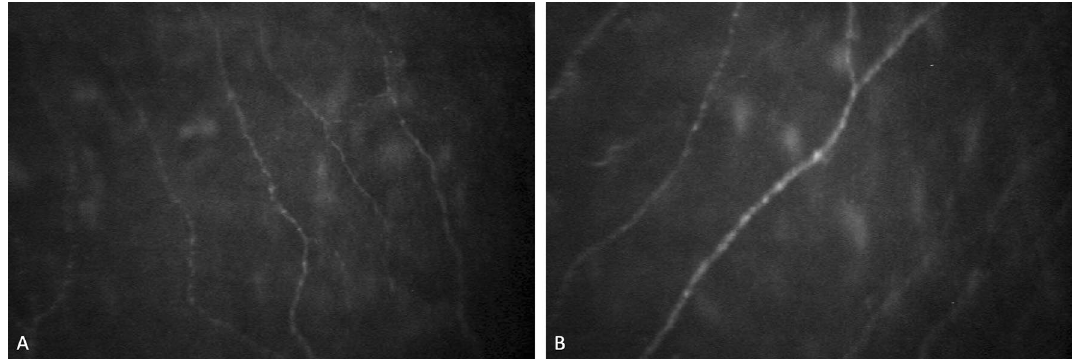
Figure 4. The SBNP fibers picture of the eye with emmetropia ( A ) and with a high myopia ( B